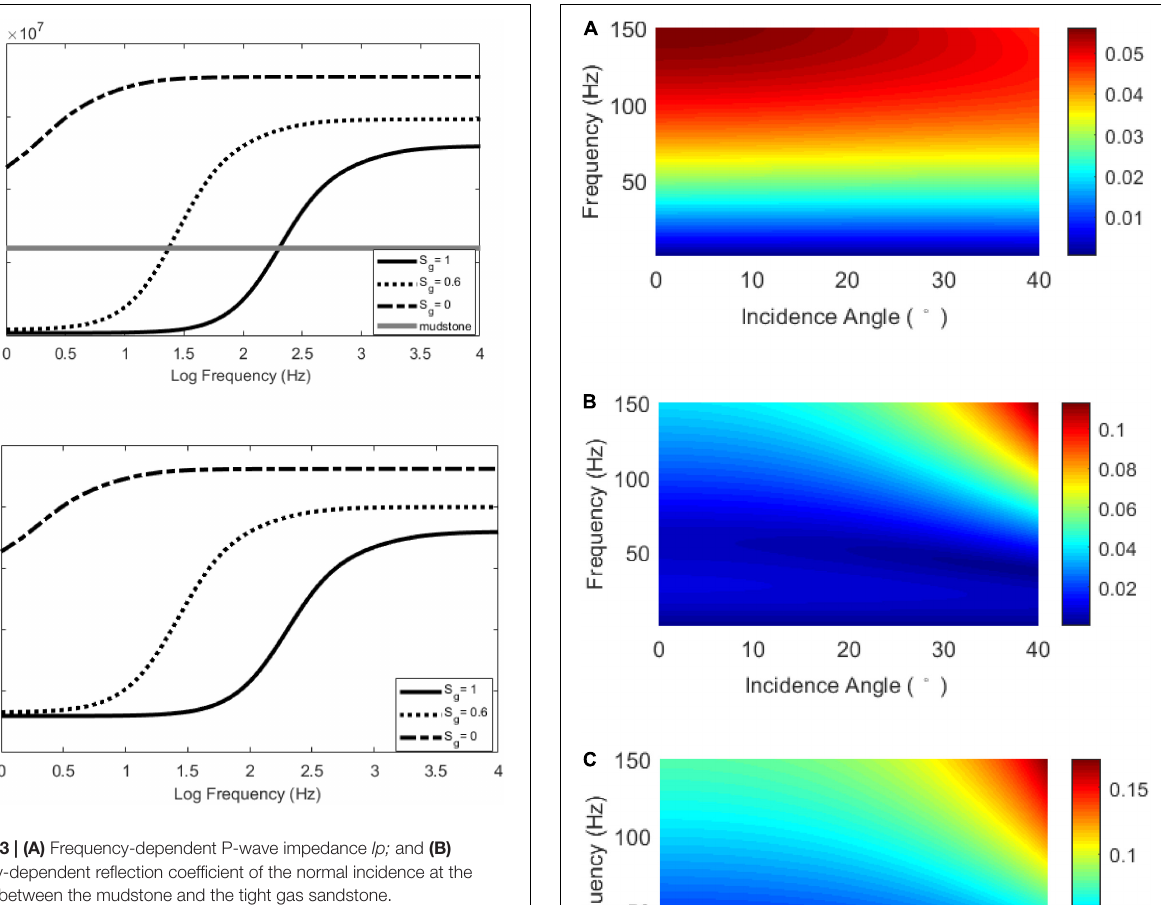
FIGURE 4 | Frequency-dependent reflection coefficients of the PP waves for gas saturations of (A) 1, (B) 0.6, and (C) 0.